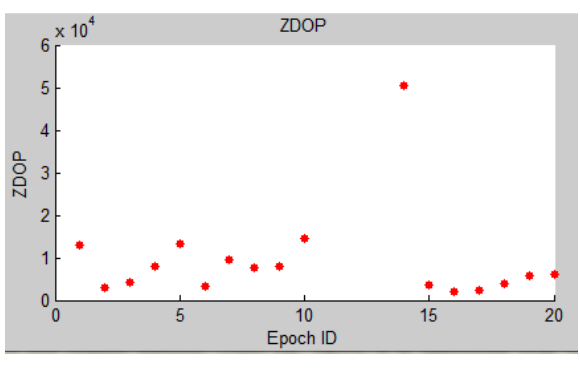
Figure 26. ZDOP of epoch